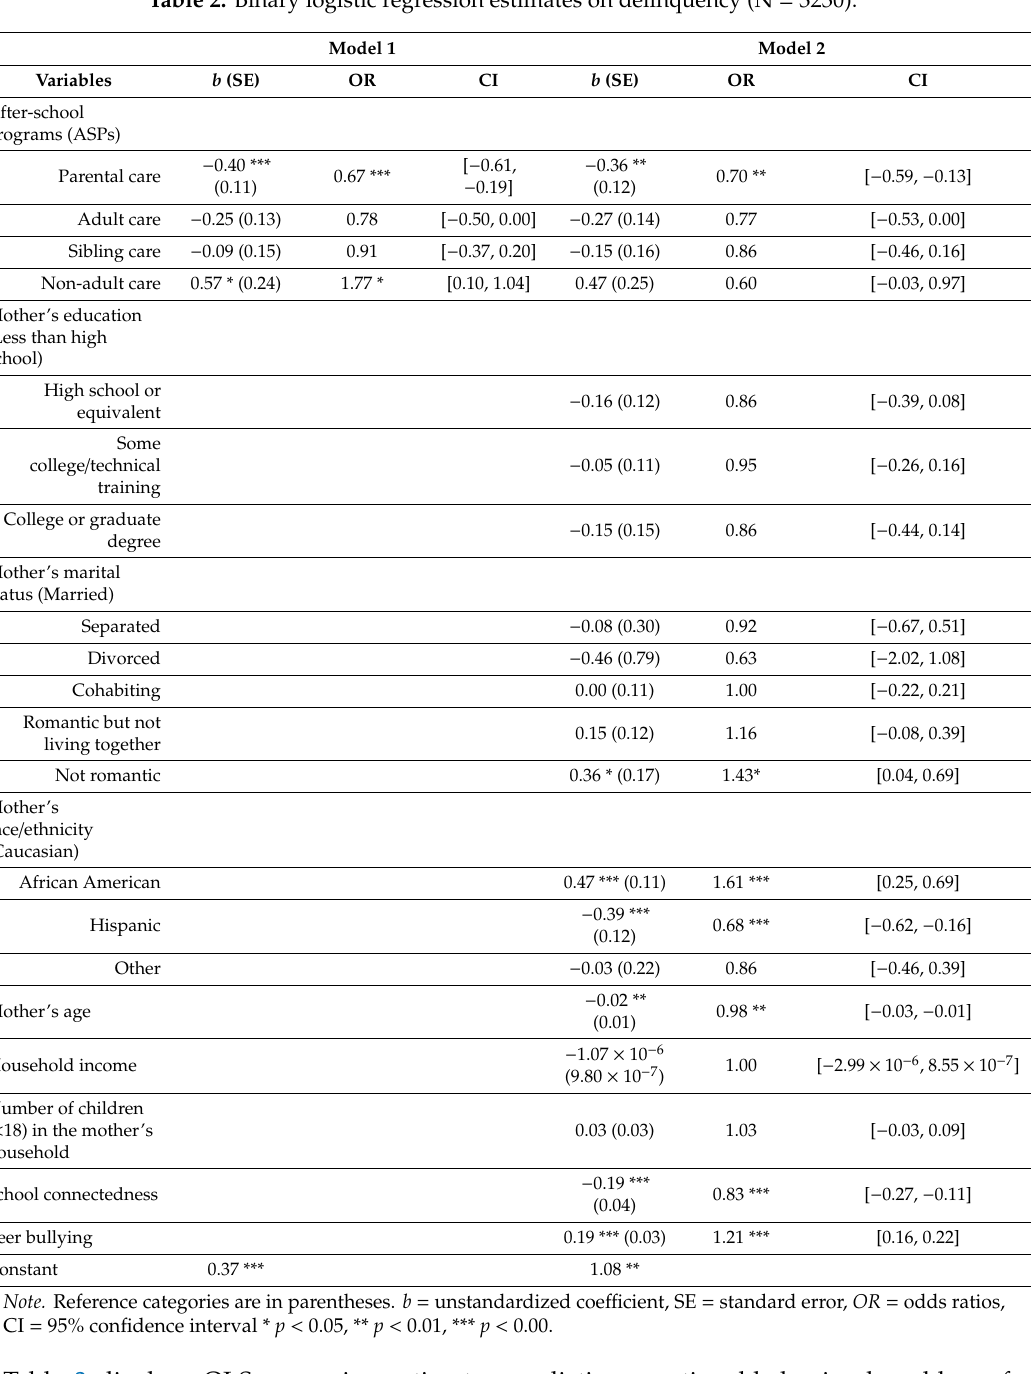
Table 2. Binary logistic regression estimates on delinquency (N =